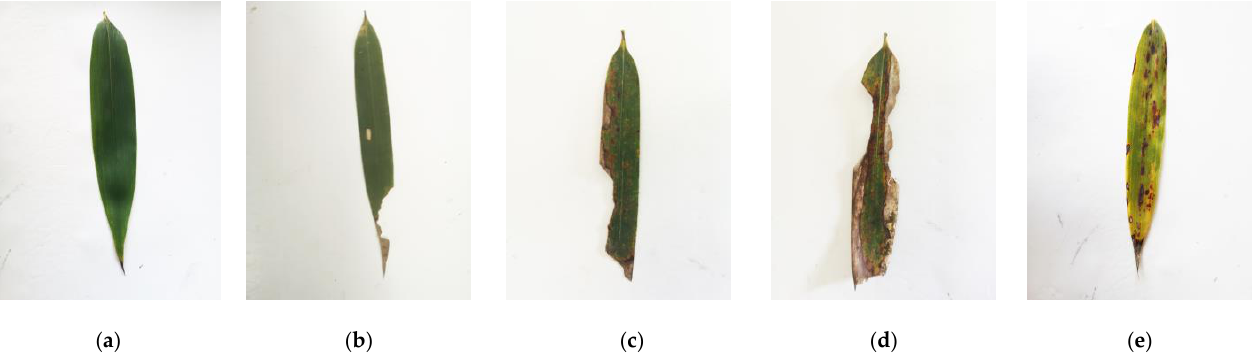
Figure 2. Leaves with different damage severities taken from the sampling bamboo in the study area: ( a ) healthy leaves; ( b ) mildly damaged leaves; ( c ) moderately damaged leaves; ( d ) severely damaged leaves; ( e ) off-year leaves.